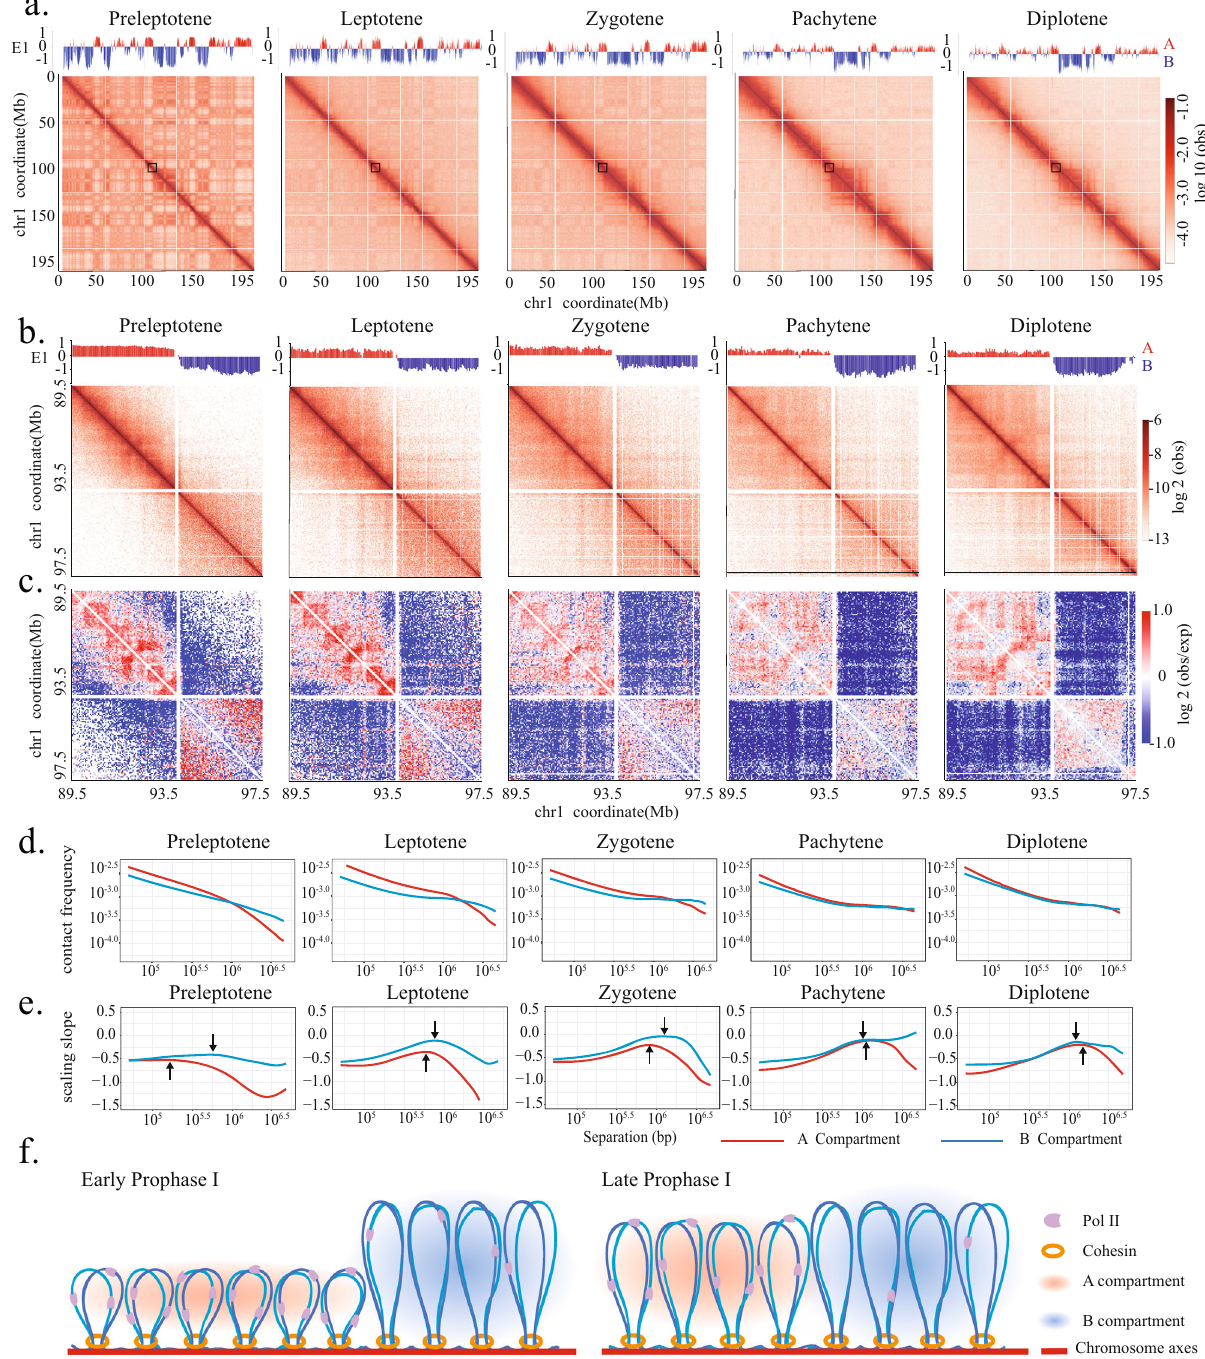
Fig. 4 Transcription-coupled variations in chromatin loop organization during early meiotic prophase. a Chr1 heatmaps binned at 50 kb resolution show attenuation of compartmentalization during meiotic prophase I. Plots of eigenvector 1 values on top of heatmaps indicate positions of A (red) and B (blue) compartments. The compartment identity is largely preserved throughout meiotic prophase I. Arrowheads indicate segments of thickened signals along diagonals, which coincide with A compartment. Close-up views of boxed regions are shown in b , c . b , c Heatmaps of observed interaction frequency ( b ) and observed/expected interaction ratio ( c ) at 20 kb resolution for a representative Chr1 region. In preleptotene, leptotene, and zygotene stages, the A and B compartment regions enrich for interactions at shorter and higher genomic separation, respectively. d P ( s ) plots show relationships between chromatin contact frequency and genomic separation for A (red) and B (blue) compartment regions during different meiotic stages. Only A and B compartment regions >2 Mb were included in this analysis. e Plots of P ( s ) slopes show chromatin loop sizes for A and B compartment regions in each meiotic prophase I substage. Arrows indicate the peak positions in P ( s ) slope curves, which correspond to the average loop sizes. The A compartment regions consist of smaller loops than the B compartment regions in preleptotene, leptotene, and zygotene stages. f Schematic illustrations show that the transcriptionally active and inactive regions exhibit different chromatin loop sizes during early meiotic prophase I. The differences become less pronounced in late meiotic prophase